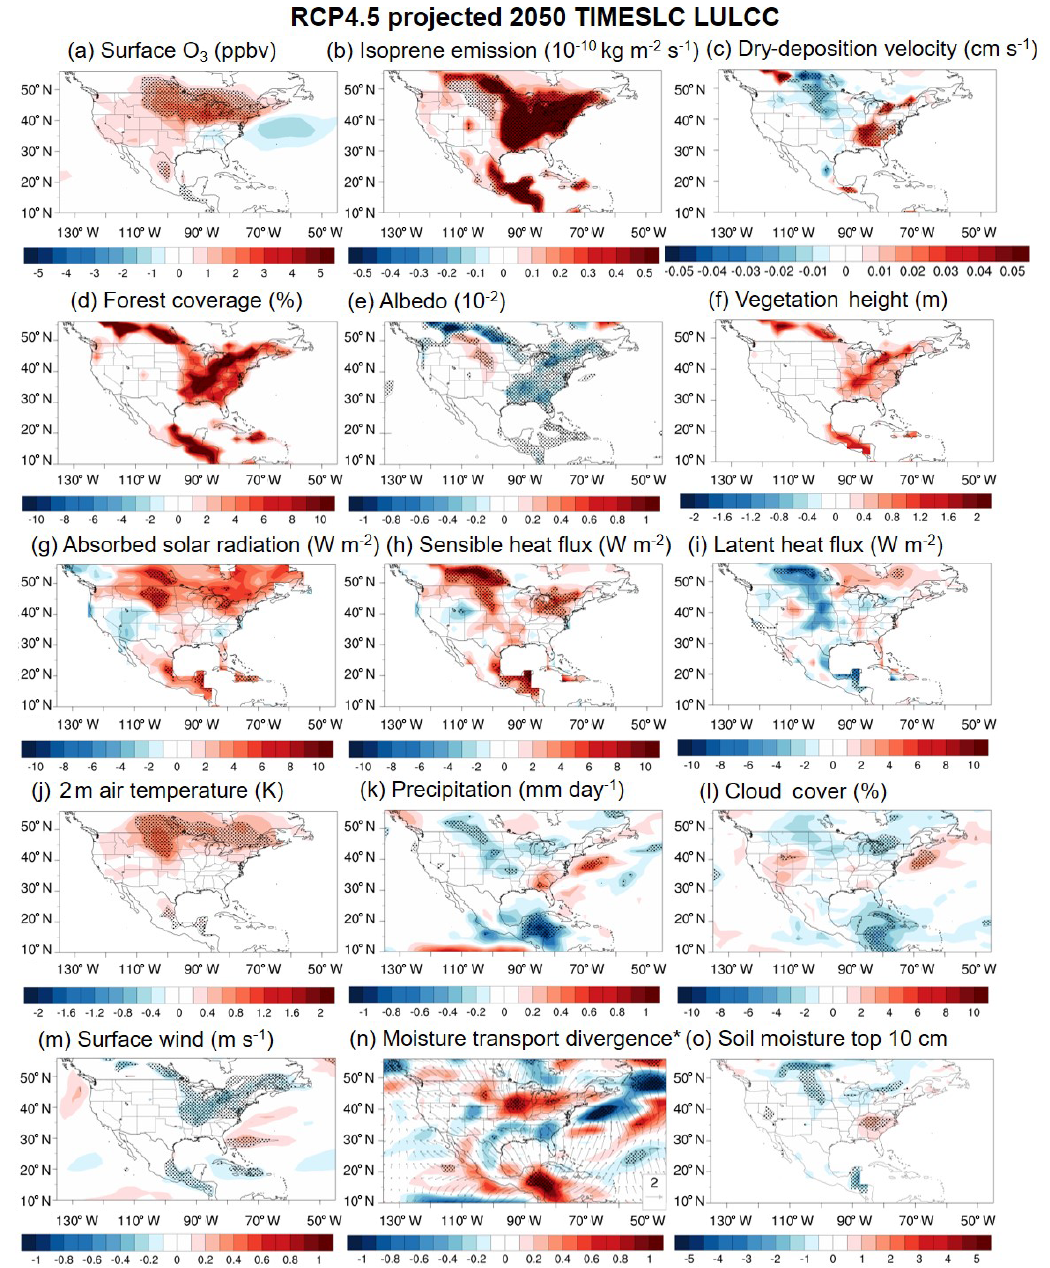
Figure 5. Changes in surface ozone, isoprene emission, dry-deposition velocity, projected forest, simulated surface albedo, vegetation height, surface net solar radiation, sensible and latent heat fluxes, 2m air temperature, precipitation, cloud cover, surface wind, vertically integrated moisture transport divergence (vector: kgm − 1 s − 1 ; shading: 10 − 5 kgm − 2 s − 1 ), and soil moisture at top 10cm layer during the boreal summer over North America due to 2000-to-2050 RCP4.5 projected LULCC. Regions with dots indicate changes that are significant at the 95% confidence